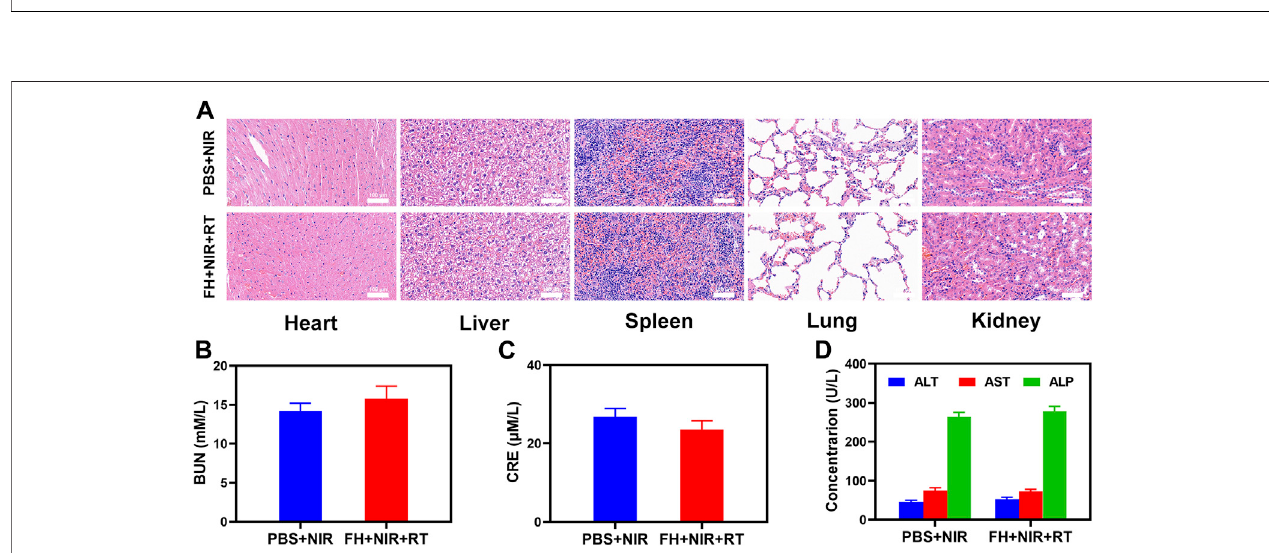
FIGURE 4 | Result of in vivo safety experiments. (A) Histopathological analysis results (H and E stained images) of the major organs, heart, lung, liver, kidneys, and spleen, of mice that were exposed to different treatments 16 days post-injection. Blood biochemistry data including kidney function markers: (B) liver function markers: BUN, (C) CRE, and (D) ALT, ALP, and AST after various treatments.